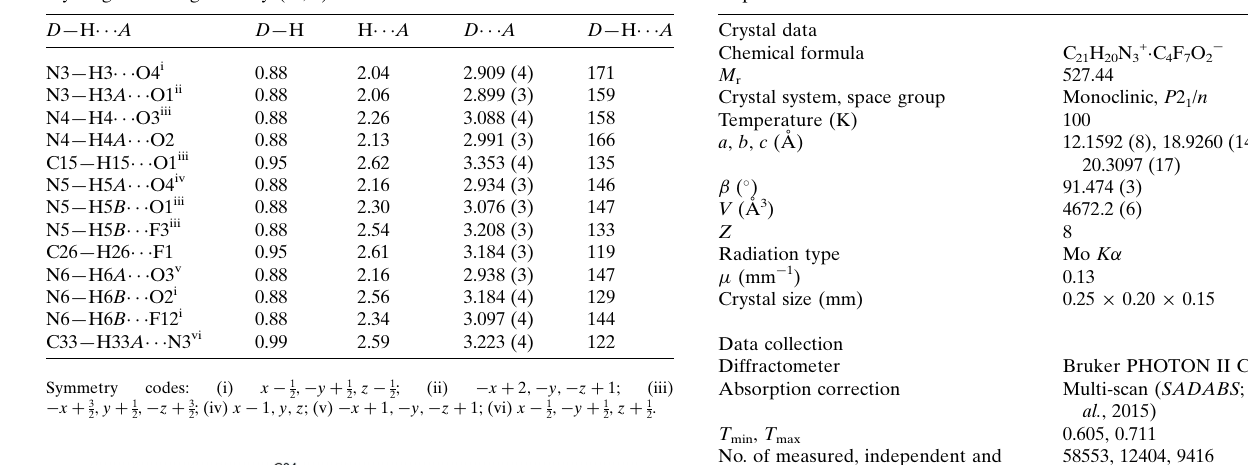
Table 1 Hydrogen-bond geometry (A˚ , (cid:4) ).